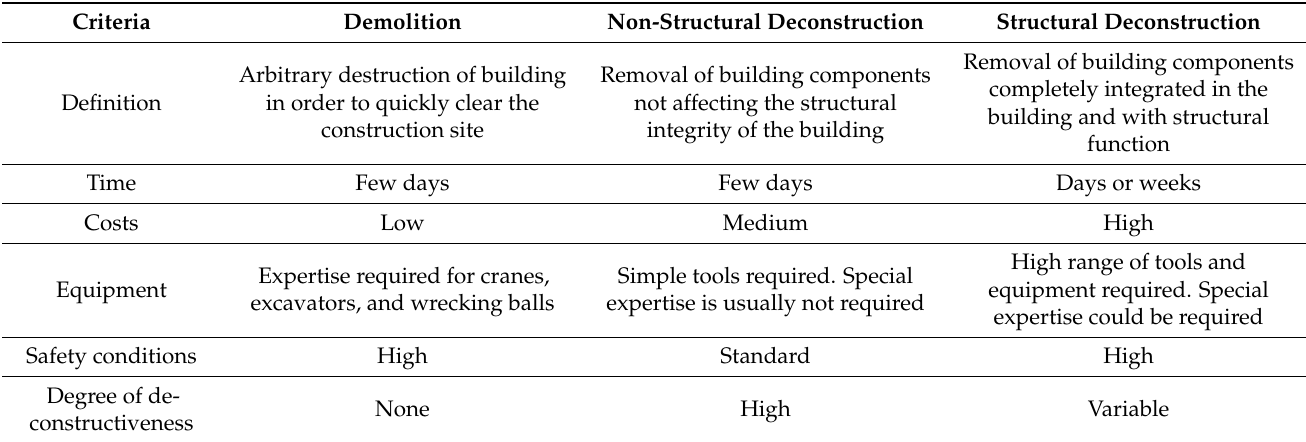
Table 4. Comparison between deconstruction and